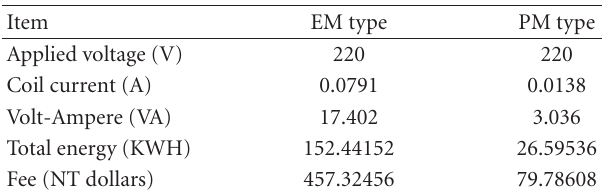
Table 2: Compare the energy-saving performance of AC EM contactor with AC PM